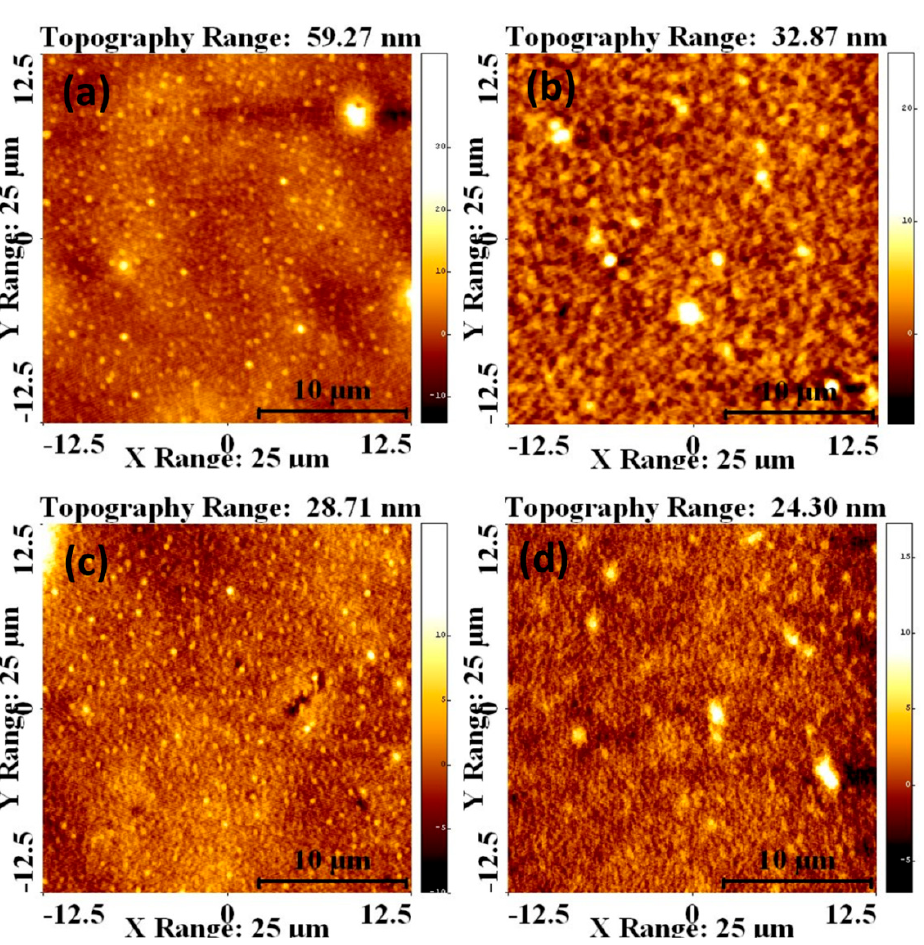
Figure 8. AFM images of the top view of the P 3 HT:PCBM:Sb 2 S 3 NC blends prepared with Sb 2 S 3 NC concentrations of ( a ) 0.01, ( b ) 0.02, ( c ) 0.03, and ( d ) 0.04 mg/mL.